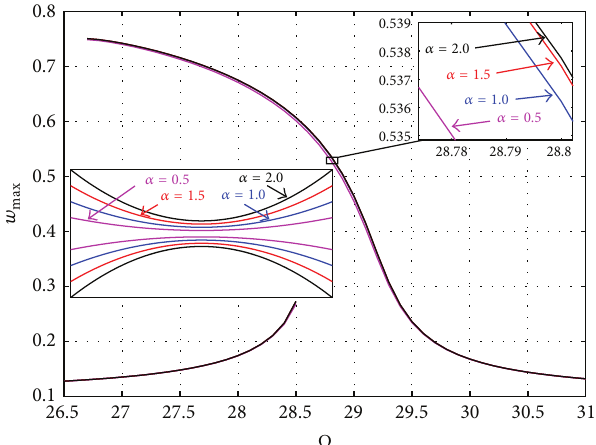
Figure11:Comparisonofdynamicresponsecurvesofdifferentmid- section width 𝑛 .